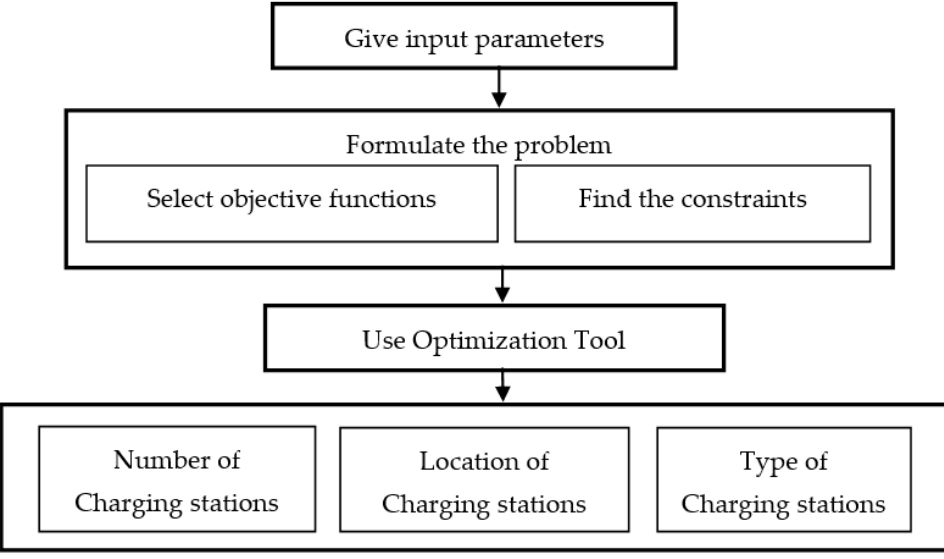
Table 2. Various objective functions of placement problem [101].